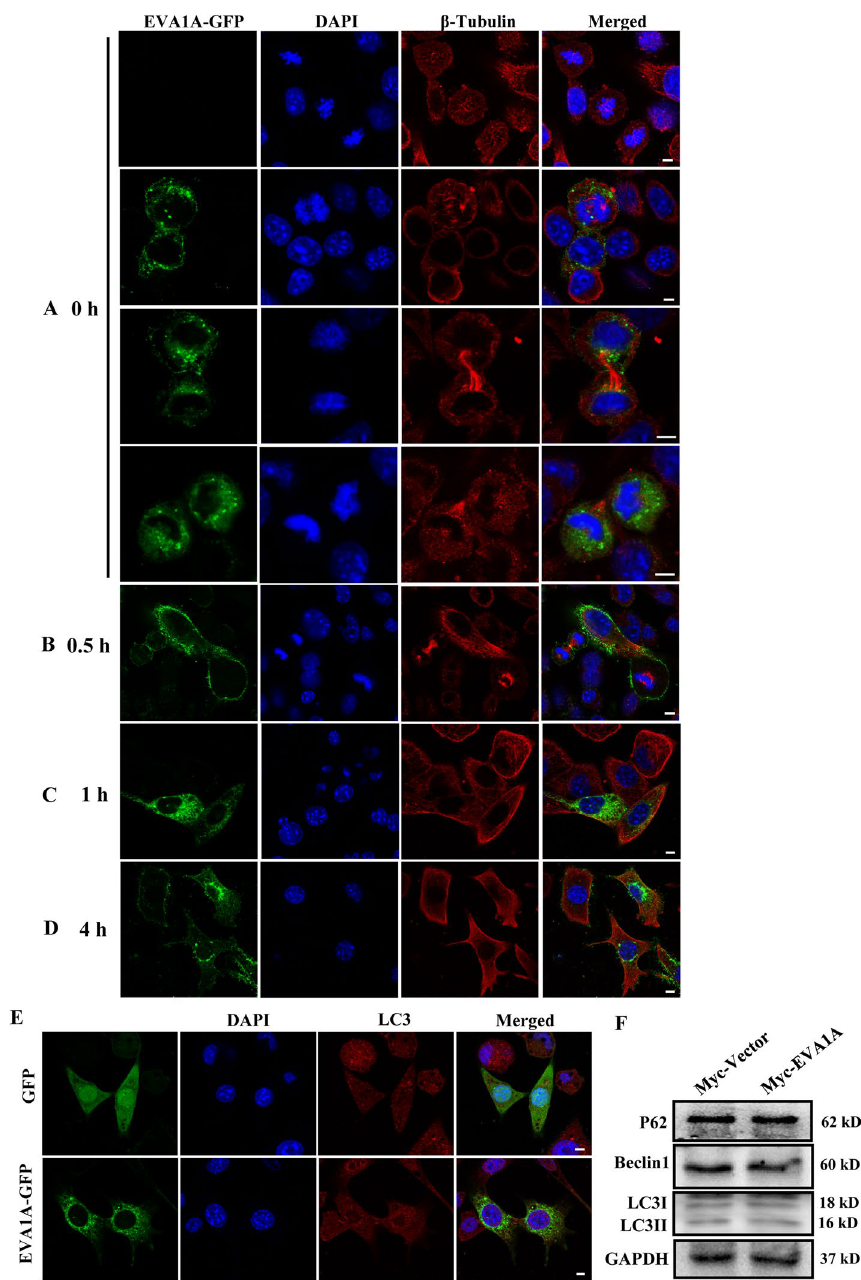
Fig. 6 Effect of overexpression EVA1A on mitotic progression and autophagy. Hccl-M3 cells transfected with EVA1A-GFP plasmid were synchronized at mitotic phase by 100 ng/ml nocodazole treatment for 14 h. 0 h ( A ), 0.5 h ( B ), 1 h ( C ) and 4 h ( D ) after removal of nocodazole, cells were fixed, stained with anti-β-Tubulin and DAPI, and imaged by confocal microscopy. Scale bars, 5 μm. ( E ) Hccl-M3 cells were transfected with GFP empty vector or EVA1A-GFP plasmid, 24 h later, cells were fixed, stained with anti-LC3 and DAPI, and imaged by confocal microscopy. Scale bars, 5 μm. ( F ) Hccl-M3 cells were transfected with Myc-tag vector or Myc-EVA1A plasmid, 24 h later, cells were lysed and subjected to western